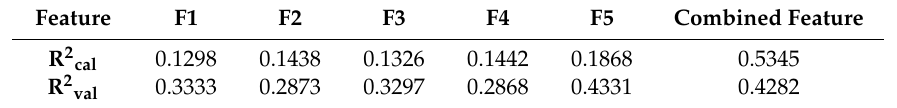
Table 4. PLSR detection results of TSS based on E-nose with different feature extraction methods.